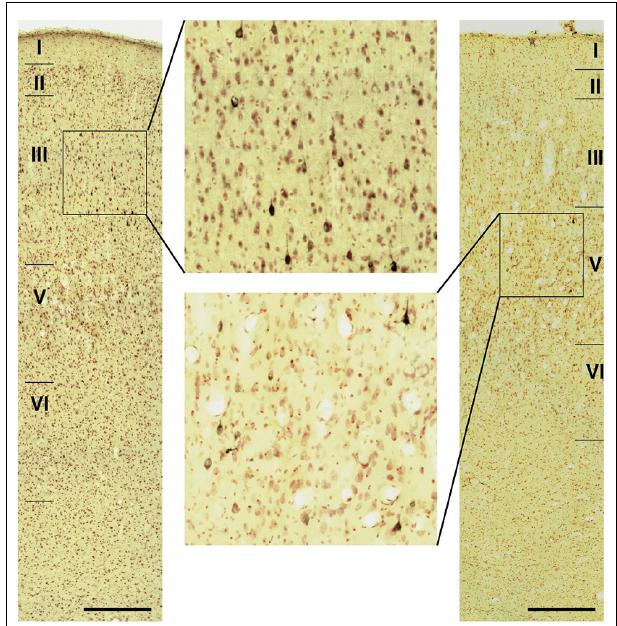
FIGURE 7 | Photomicrographs of the TP (TPag) in cases N549l-sg (left) and M2303r-pgd (right). The areas including labeled neurons are enlarged. Scale bar: 500 µ